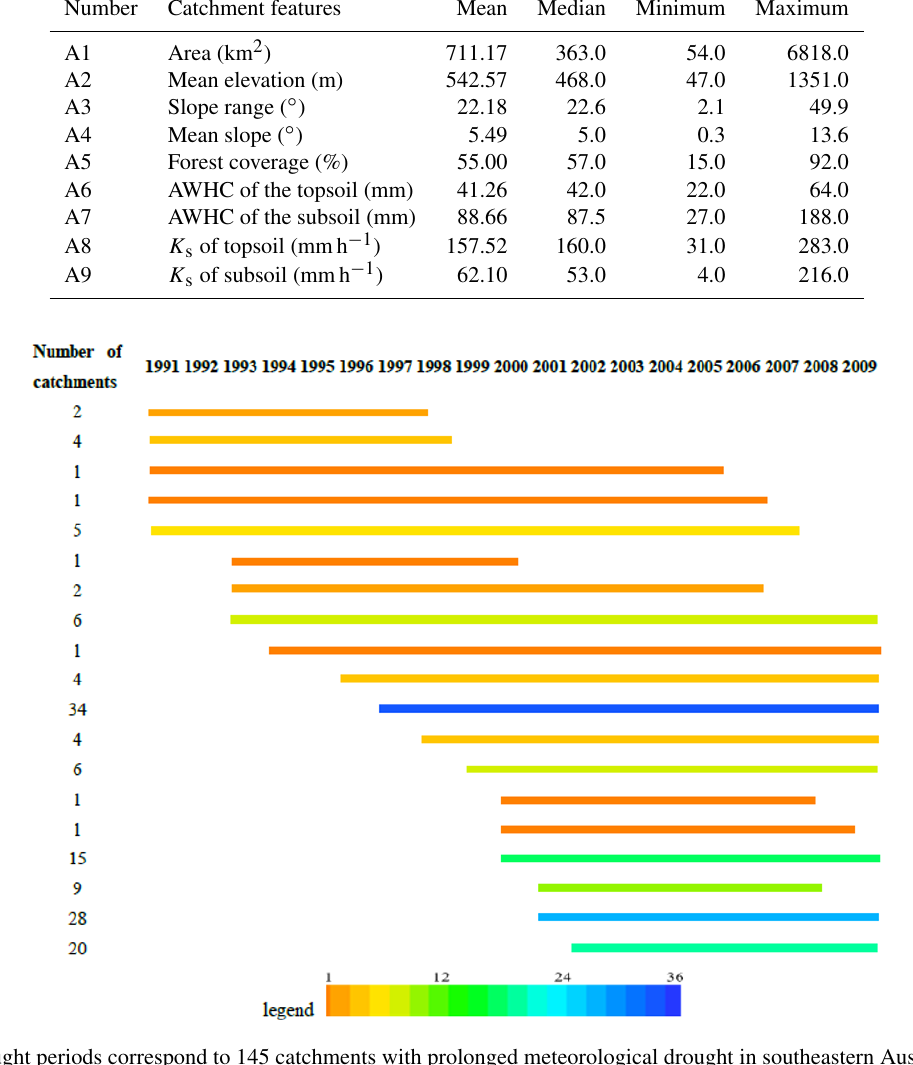
Figure 2. The drought periods correspond to 145 catchments with prolonged meteorological drought in southeastern